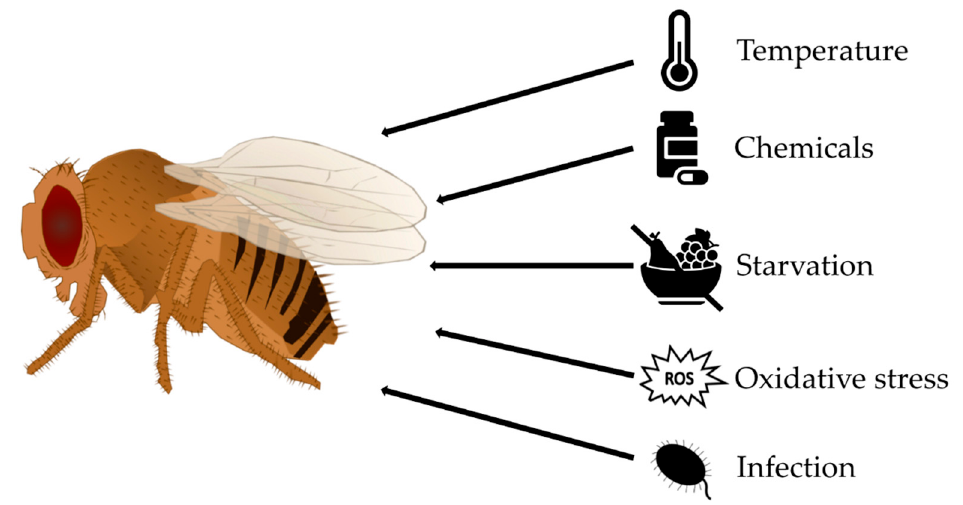
Figure 11. Overview of stress assays established in Drosophila melanogaster . The fruit fly model offers an opportunity to study the impact of dietary interventions such as high-sugar and high-fat diets on the stress tolerance of an organism. To this end, various stress assays were established, in which flies are exposed to high or low temperatures, chemicals, pharmaceuticals, starvation, desiccation or infection with pathogenic microorganisms such as Pseudomonas aeruginosa or Pseudomonas entomophila.